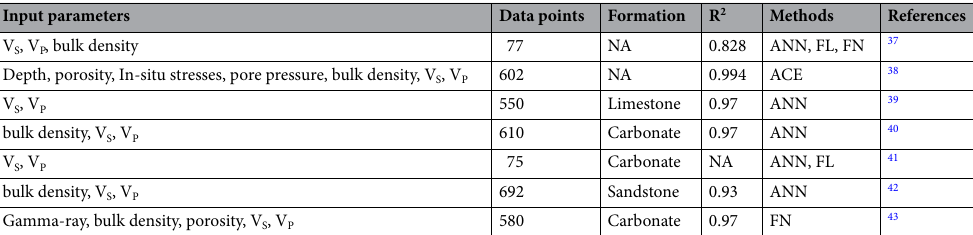
Table 2. Different correlations for static Poisson’s ratio developed using